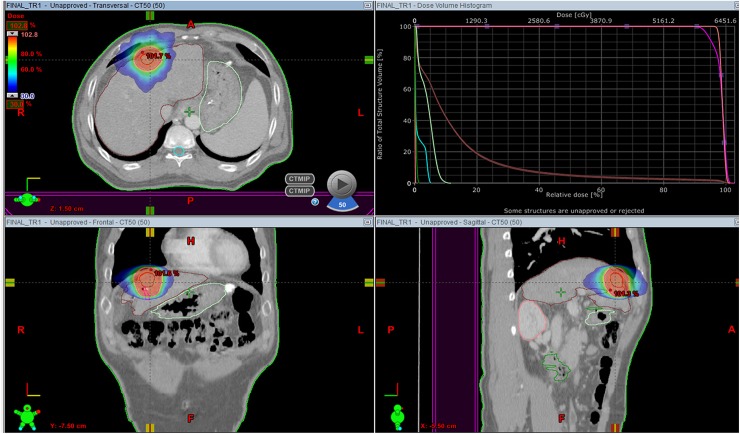
An example of radiotherapy planning using a respiratory-gated, volumetric-modulated, arc therapy technique for hepatocellular carcinoma in segment 3 of the liver.